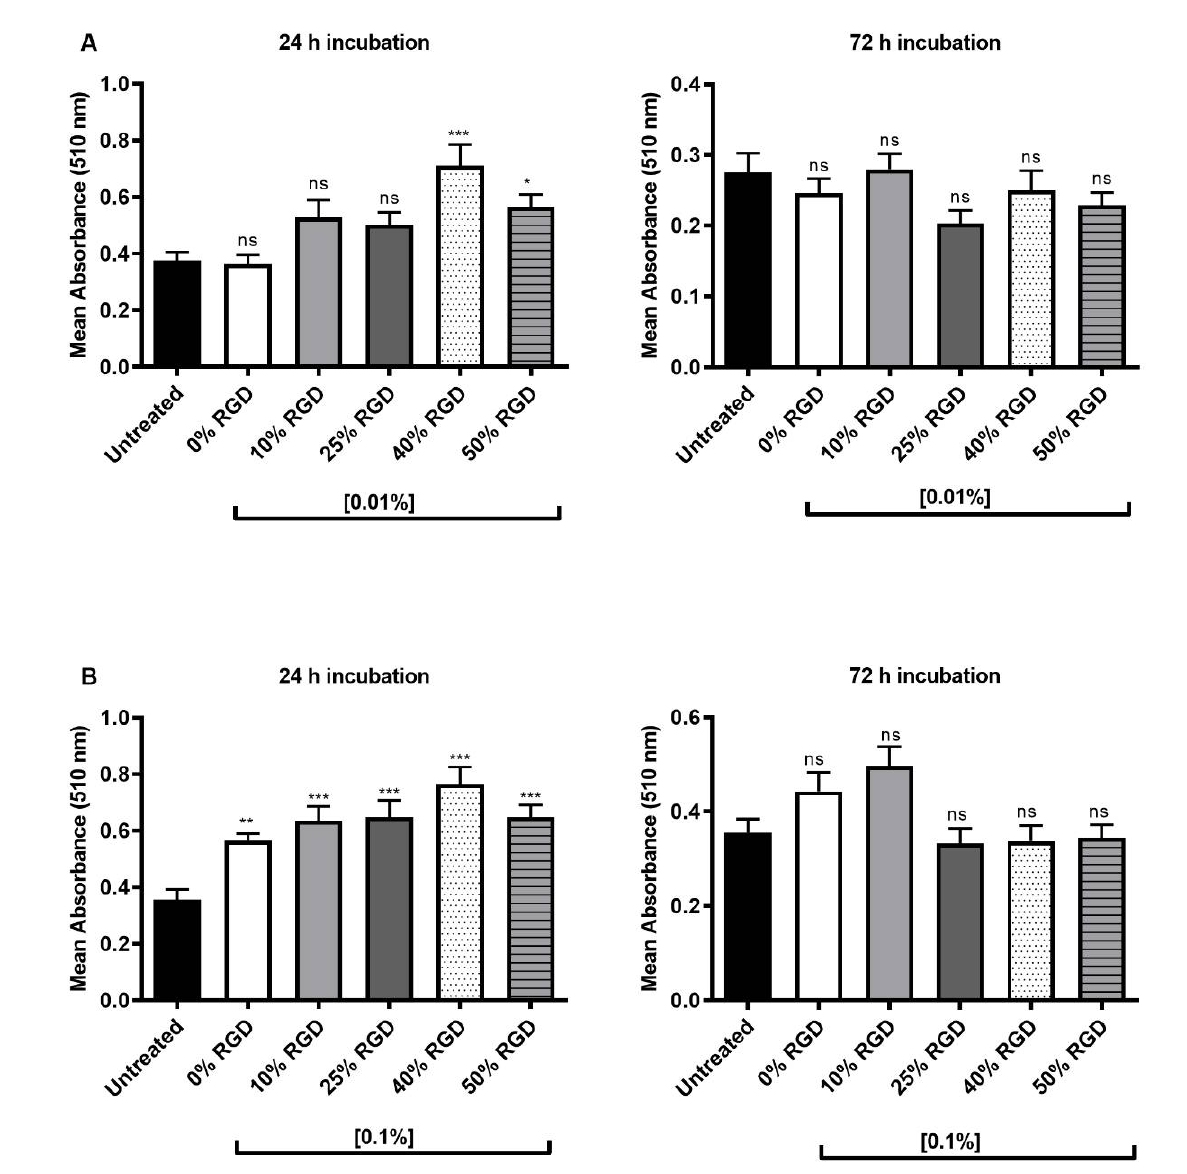
Figure 1. Biocompatibility studies of Stro-1 DPSCs with 0.01 and 0.1% w / v soluble forms of multicomponent peptides (0–50% RGD), as determined by the MTT assay. ( A ) Treatment of Stro-1 DPSCs with peptide concentrations of 0.01% w / v for 24 and 72 h. ( B ) Treatment of Stro-1 DPSCs with peptide concentrations of 0.1% w / v for 24 and 72 h. All comparisons were made with the untreated control. Data are from three experiments, with at least three replicates per experiment. Kruskal–Wallis test with Dunn’s correction for multiple comparison testing. ns: non-significant; ( p > 0.05), *: p ≤ 0.05, **: p ≤ 0.01, ***: p ≤ 0.001 .